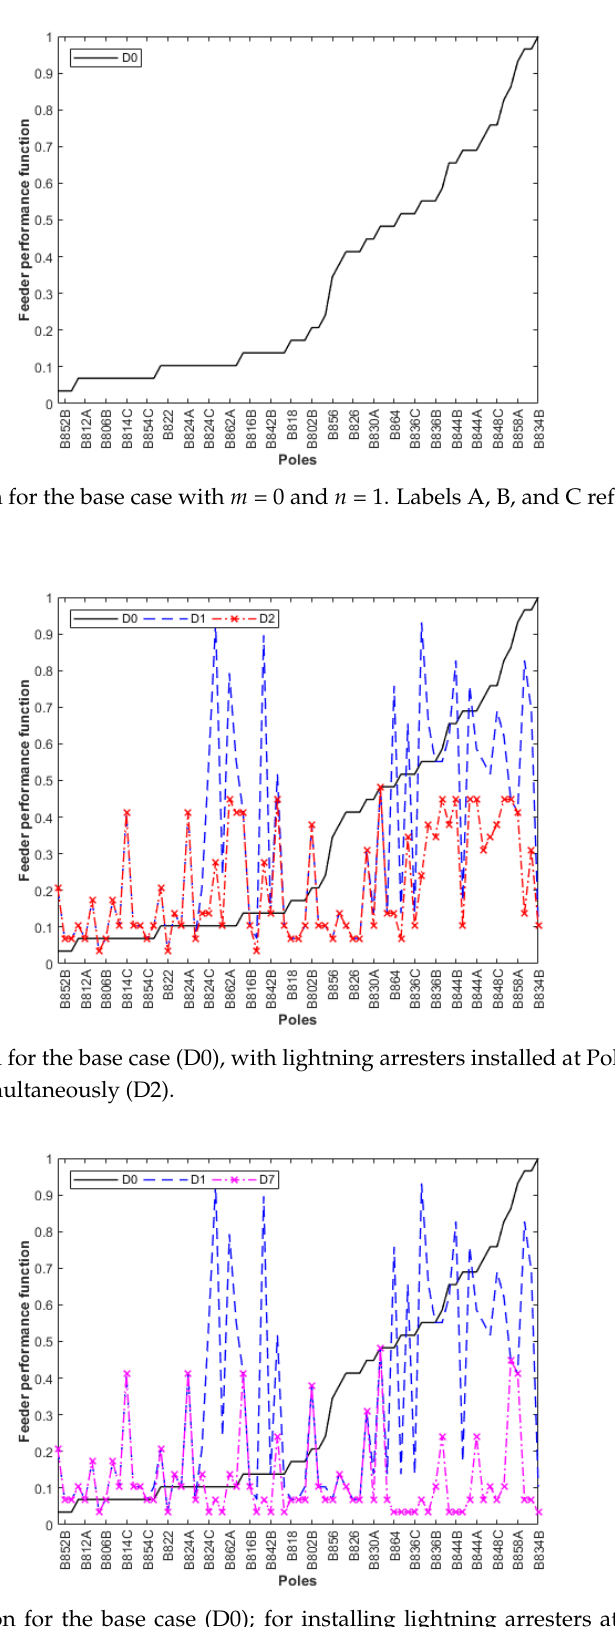
Figure 14. D function for the base case (D0); for installing lightning arresters at the transformer pole alone (D1); and installing lightning arresters at the most critical poles including the transformer pole